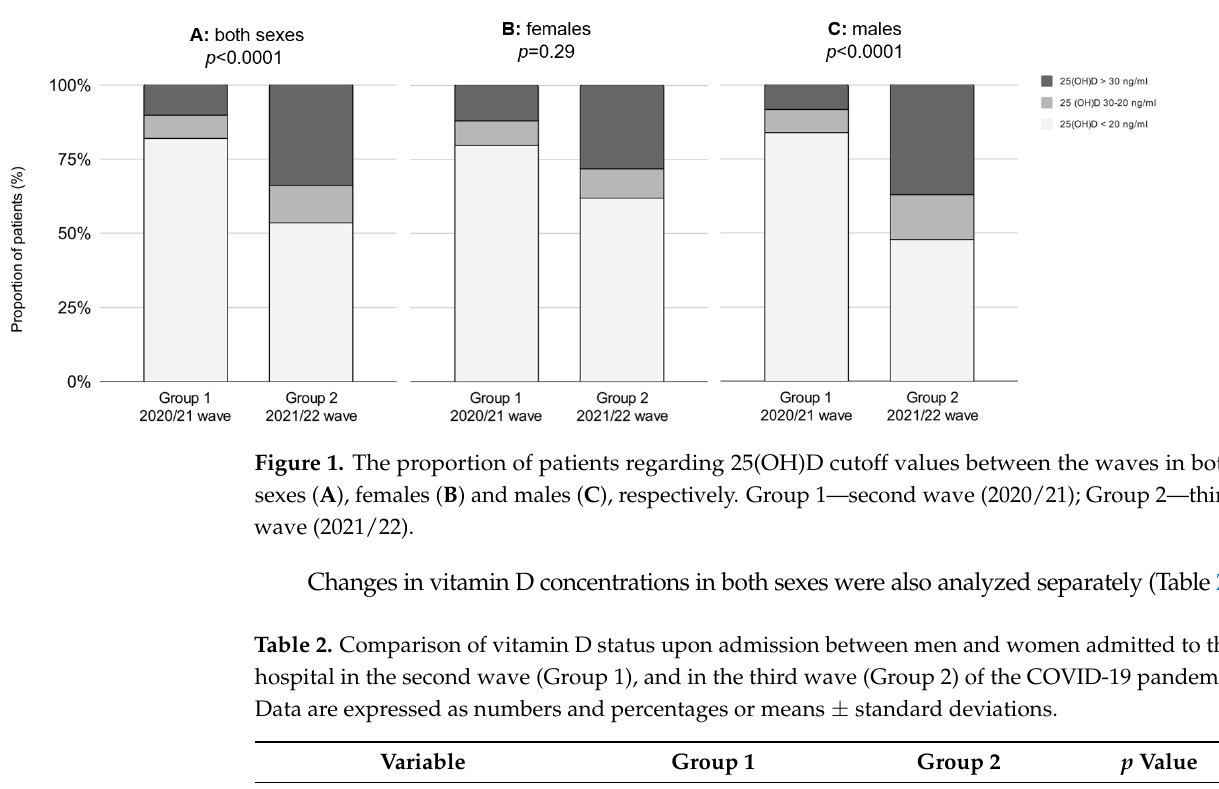
Table 2. Comparison of vitamin D status upon admission between men and women admitted to the hospital in the second wave (Group 1), and in the third wave (Group 2) of the COVID-19 pandemic. Data are expressed as numbers and percentages or means ± standard deviations.